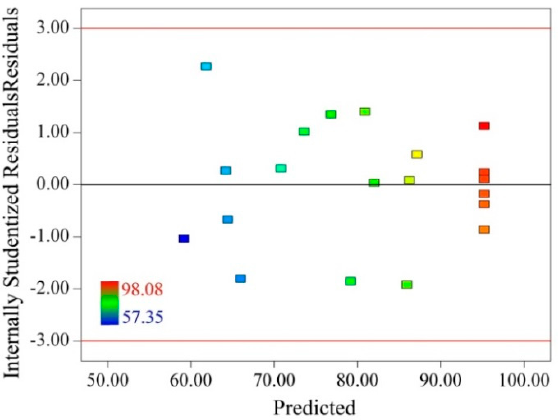
Figure 3. The predicted responses versus the residual ones.